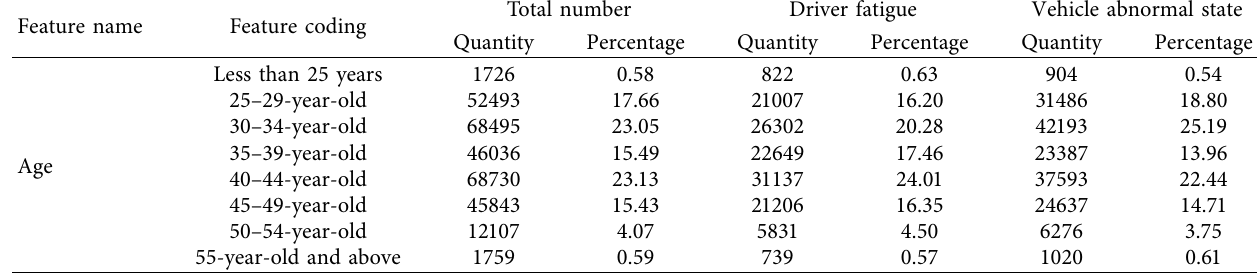
Table 7: Distribution of forewarning types of buses for drivers of different ages.